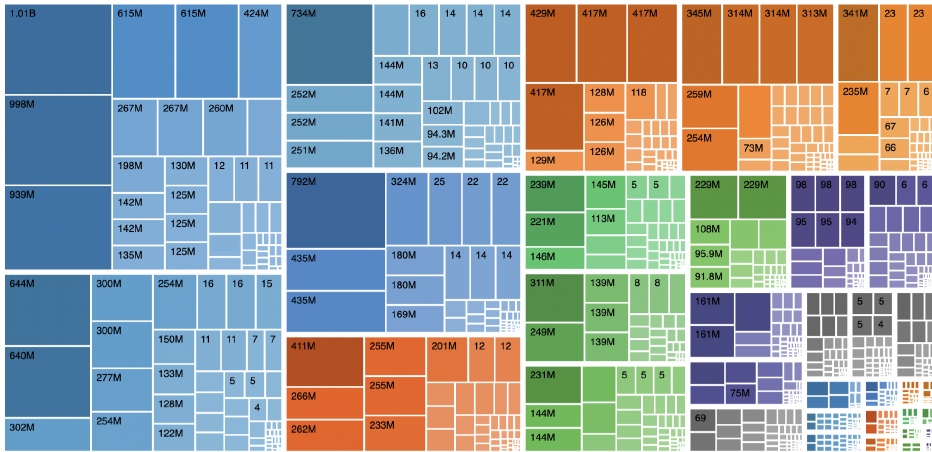
Figure 2. UI mockup proposal of a treemap visualisation.